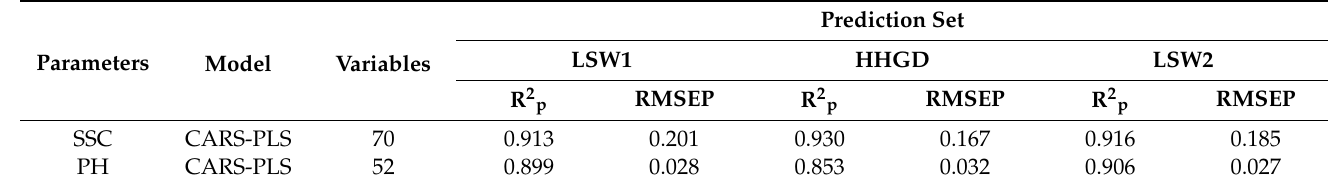
Table 9. Validation results for the 19-year